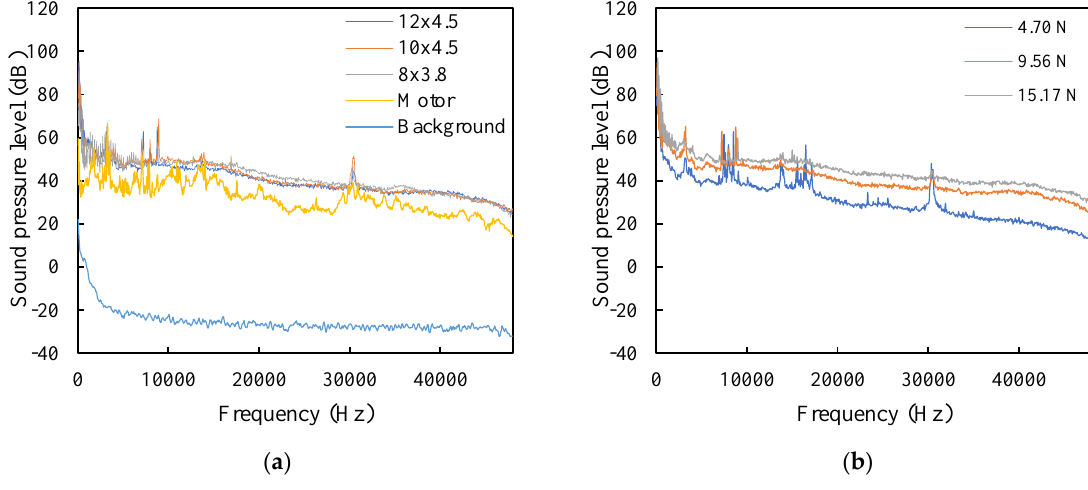
Figure 7. Acoustic noise spectrum of the quadcopter noise at 9.73 N thrust ( a ) and spectrum change with thrust using propeller model 10 × 4.5 ( b ).